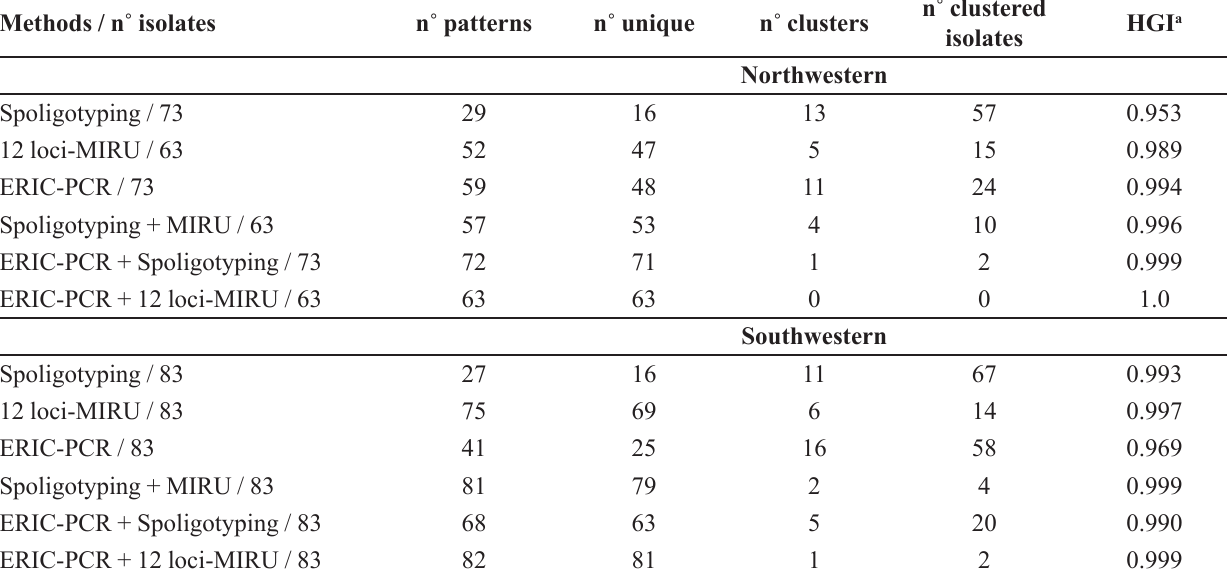
TABLE I - Discriminatory power of Enterobacterial Repetitive Intergenic Consensus sequence (ERIC-PCR), Spoligotyping and 12 loci-MIRU-VNTR typing, alone and in association in Mycobacterium tuberculosis Methods / n˚